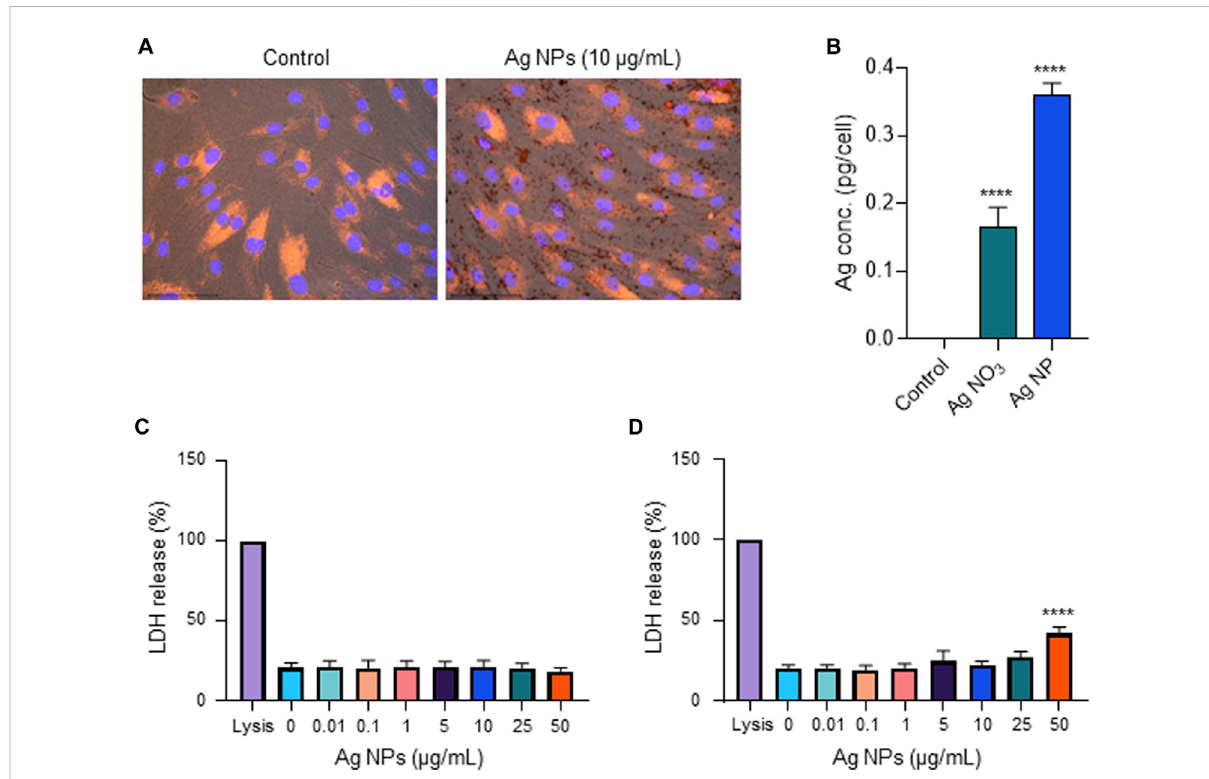
FIGURE 6 Biocompatibility assessment using primary cells. (A) Cellular uptake of Ag-B NPs (25 μ g/ml) in primary human nasal epithelial cells (HNEC) was determined at 24 h using fl uorescence microscopy. DAPI (blue): cell nuclei; phalloidin red: actin. The dark granules in the panel to the right are suggestive ofcellular uptakeand/orcellularattachmentoftheAgNPs. (B) ICP-MS showed increased intracellular Agcontentincellsexposed to Ag- BNPs(10 μ g/ml),andalowercellularcontentincellsexposedtoAgNO 3 attheequivalentconcentration.Datapresentedaremeanvalues±S.D. ( n =3).**** p < 0.0001. (C,D) CellviabilityofHNECmaintainedinserum-freeNECMwasevaluatedusingtheLDHreleaseassayfollowingexposureto Ag-B NPs for 24 h (C) and 48 h (D) , respectively. Data shown are mean values ±S.D. ( n = 3). **** p <